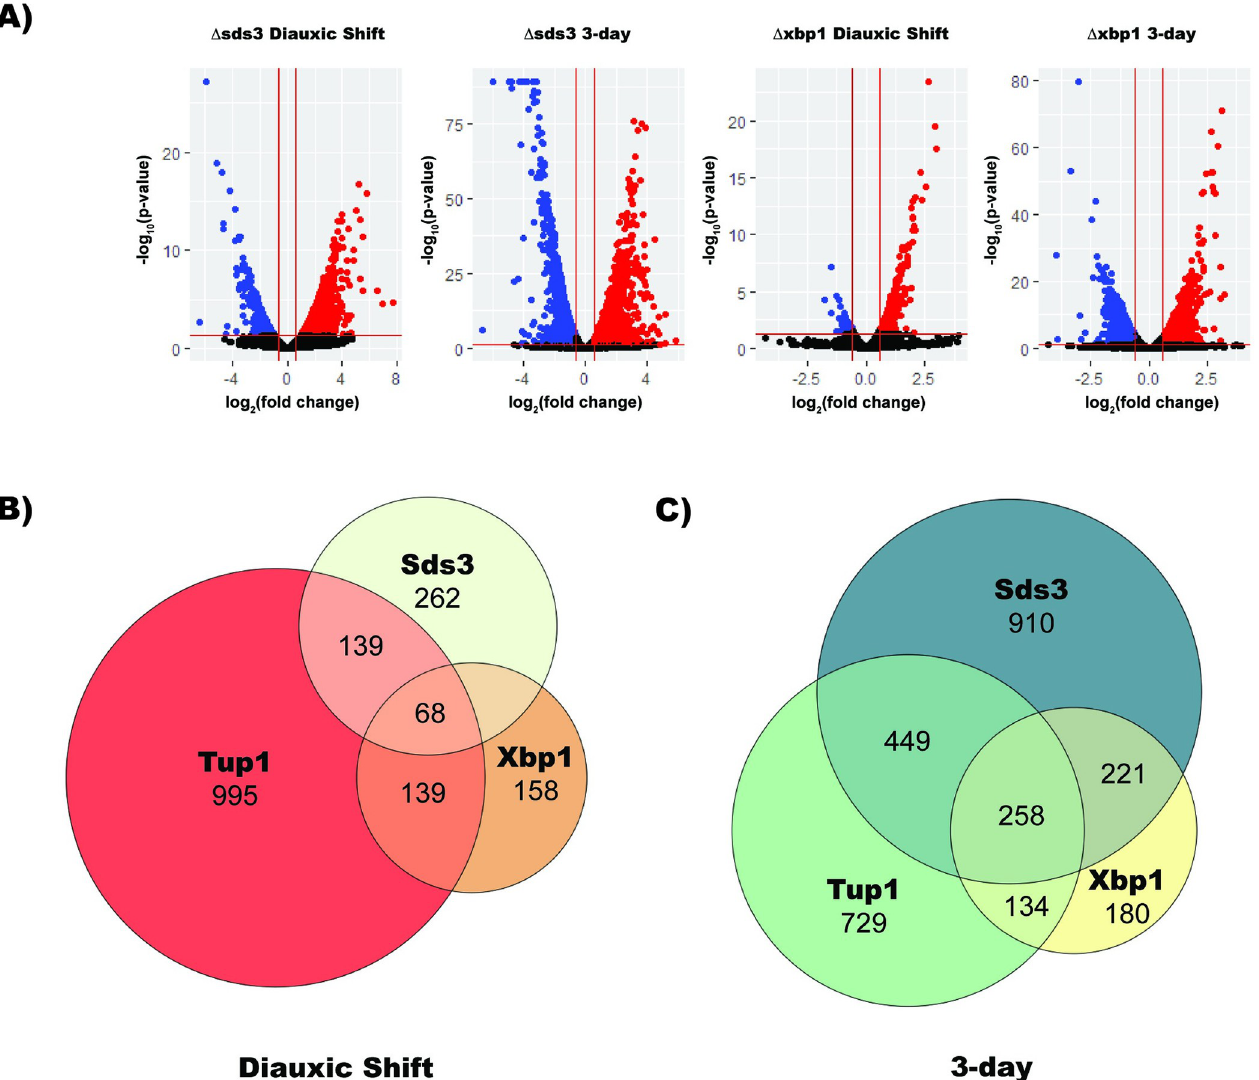
Fig 3. Sds3 and Xbp1 Repress Targets in Common with Tup1. (A) Volcano plots of RNA-Seq differential expression data comparing Xbp1 and Sds3 deletions to wild type in both diauxic shift and stationary phase. Expression changes are based on two biological replicates. (B) Venn diagram of transcripts repressed by Tup1, Sds3, and Xbp1 in diauxic shift. (C) Venn diagram of transcripts repressed by Tup1, Sds3, and Xbp1 in stationary